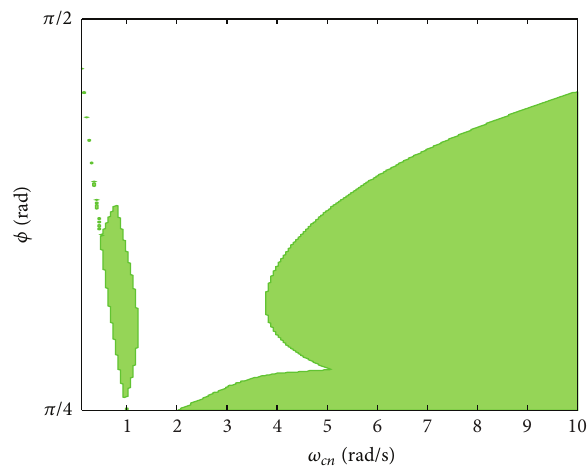
controller and the frequency specifications volume Δ(𝜔 𝑐𝑛 , 𝜙, 𝛼) for the 𝑃𝐼 𝛼 , 𝐼𝐼 𝛽 , and 𝐼 𝛼 𝐷 1−𝛼